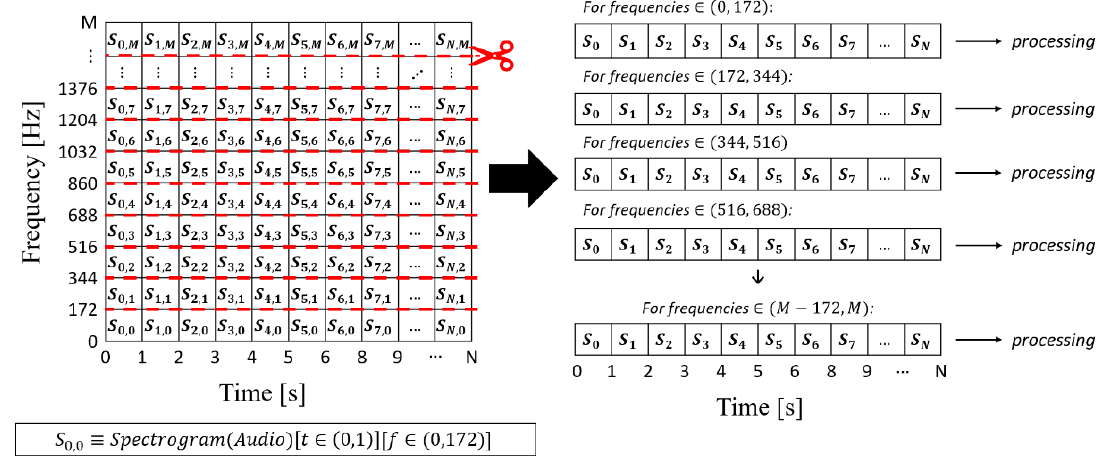
Figure 6. Procedure of slicing spectrogram to multiple signals, where each represents signal power in time for one specified frequency.